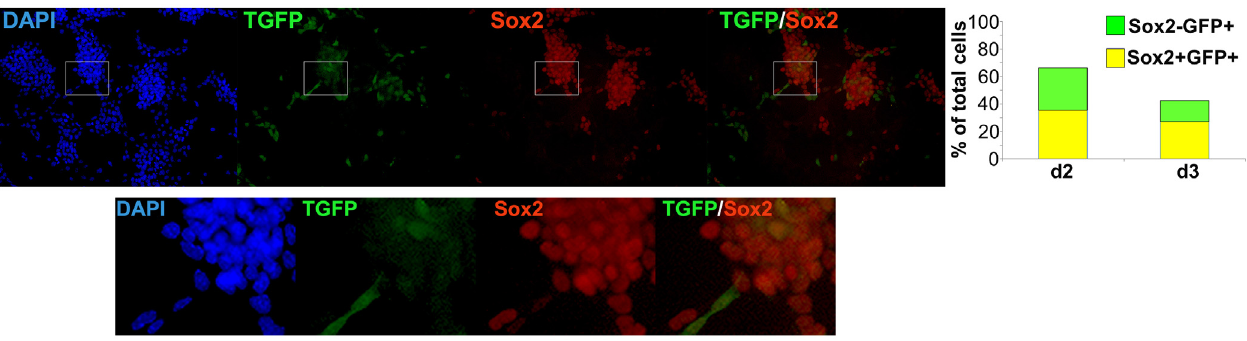
Figure 1. Left : Fluorescence analysis of TGFP and Sox2 expression in TGFP EpiSCs cultured for 48 hours in FGF2/CHIR following antibody staining against Sox2. Right : Quantification of TGFP + Sox2 + and TGFP + Sox2 - expressing cells in TGFP EpiSCs differentiated in NMP-inducing conditions after 2 (d2) or 3 (d3) days following immunocytochemistry and image analysis. Magnified versions of the areas marked by a white box are shown in the bottom panel.